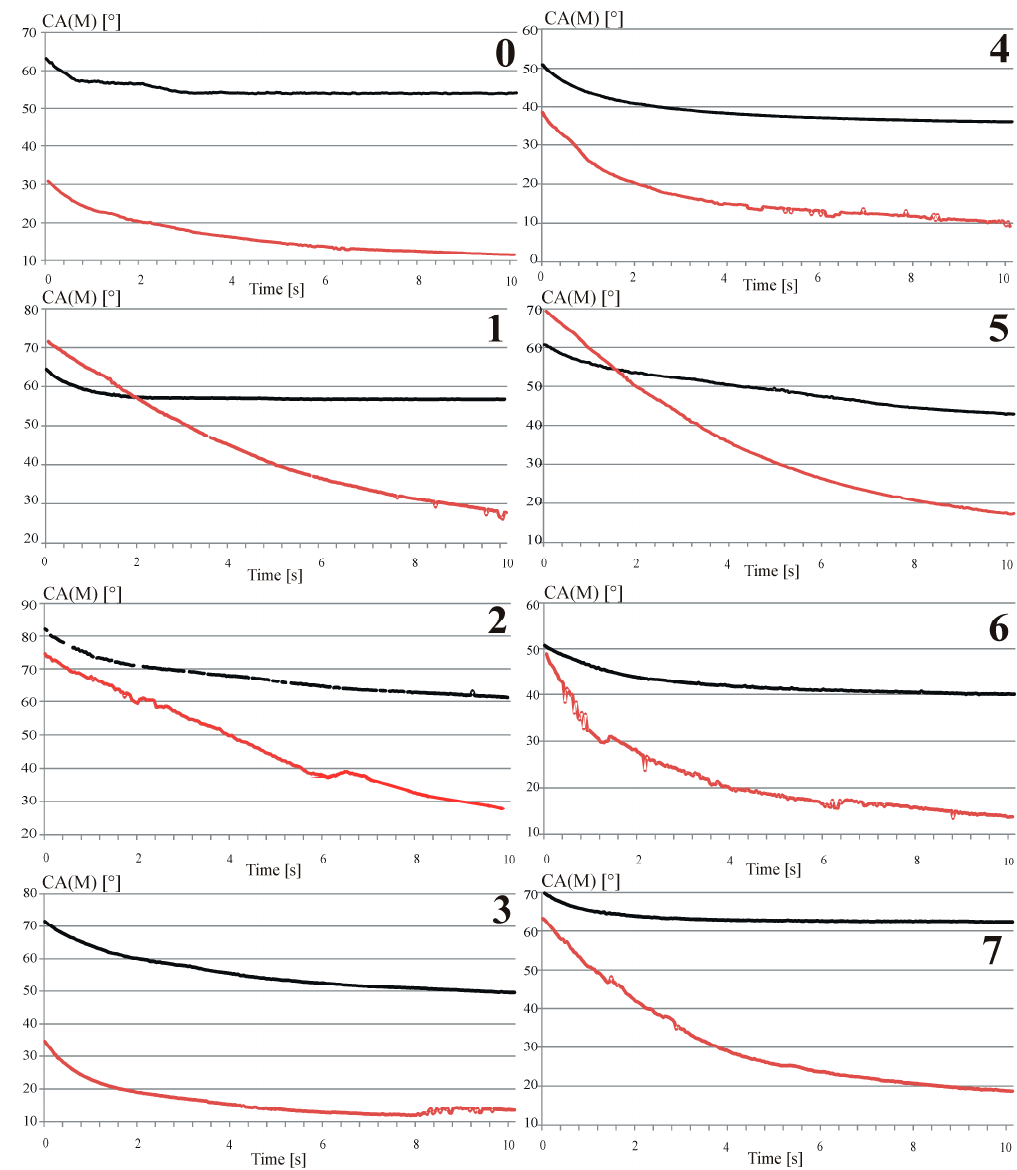
Figure 5. The contact angle characteristic as a function of time for the base (black) and hydrothermally treated surfaces (red) marked in accordance to sample composition. ( 0 ): Mg pure—Reference sample; ( 1 ): Mg4Y5.5Dy0.5Zr; ( 2 ): Mg4Y5.5Dy0.5Zr + 5%BG; ( 3 ): Mg4Y5.5Dy0.5Zr + 5%BG